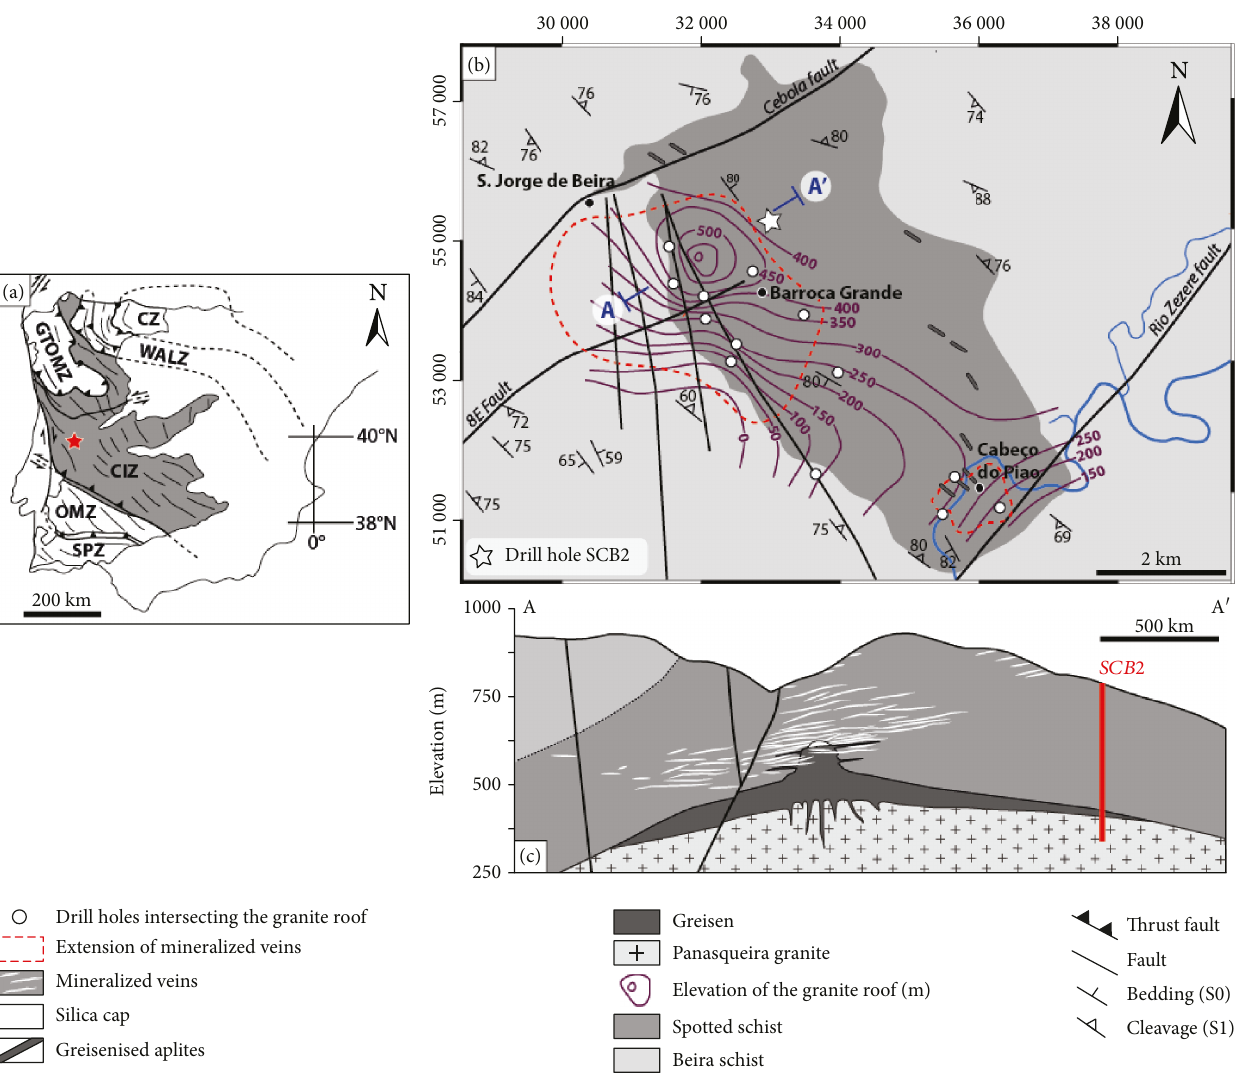
Figure 1: (a) Location of the Panasqueira ore deposit in the Iberian Variscan belt (red star). (b) Geological map of the Panasqueira W-Sn-(Cu) ore deposit including the location of the drill hole SCB2 (white star) used in this study. (c) The (A-A ′ ) geological cross section displays the spatial relationship between the mineralized veins and the massive greisen constituting the top of the granite intrusion (data source Beralt Tin & Wolfram S.A.) (modi fi ed from [35]). Abbreviations, CZ: Cantabrian Zone; WALZ: West Asturian-Leonese